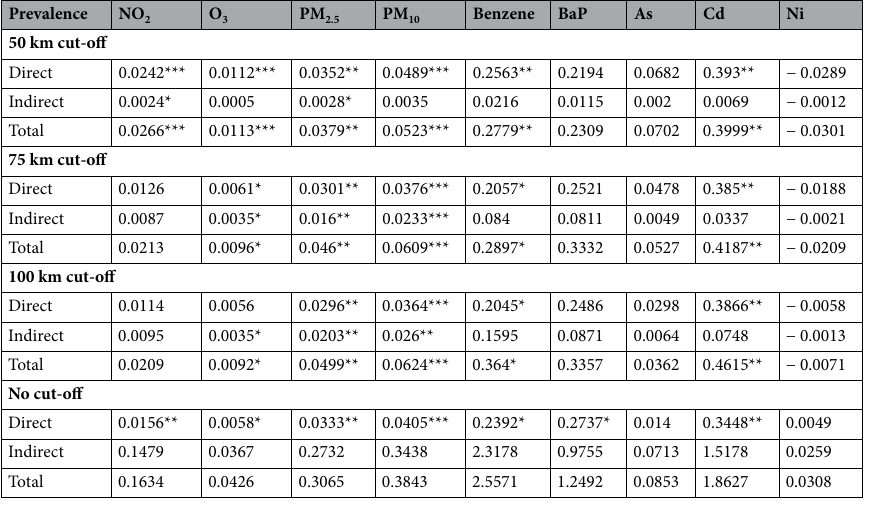
Table 13. Direct, indirect, and total effects of air pollutants after fitting SAR models on COVID-19 prevalence (on 30 November 2020). p-value < 0.01***; p-value < 0.05**; p-value < 0.1*.